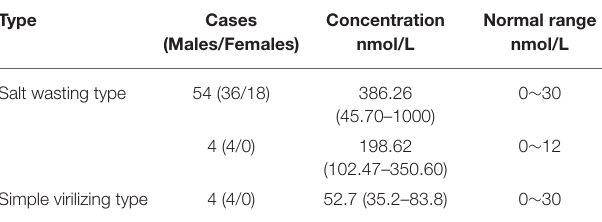
TABLE 2 | Summary of 17-OHP concentrations from initial screening.